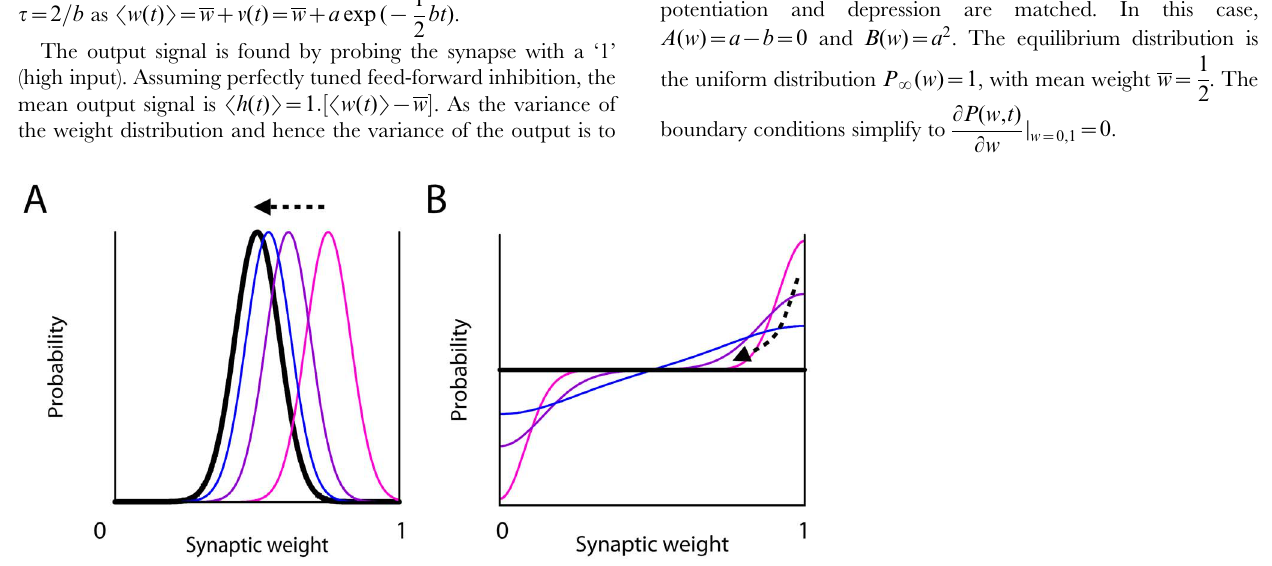
Figure 6. Illustration of decay of the weight distributions after a potentiation event. The distribution right after the potentiation is shown by the magenta curve; as time progresses (indicated by the arrow) it decays back to the equilibrium distribution (thick black curve). A) With soft- bound plasticity the distribution is displaced but maintains its shape. During the overwriting it shifts back to the equilibrium distribution. B) With hard-bound plasticity, the distribution distorts after the potentiation due to the presence of the bounds. As it decays back to the equilibrium this distortion flattens out.